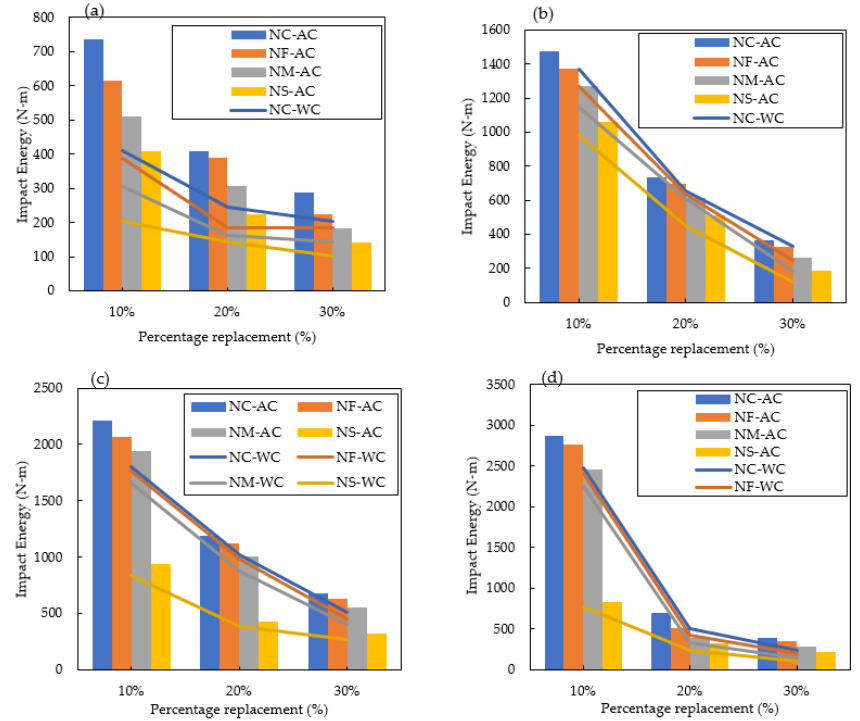
Figure 7. Impact energy versus percentages of nanomaterials in various grades at 250 °C: ( a ) M20; ( b ) M30; ( c ) M40; ( d ) M50.